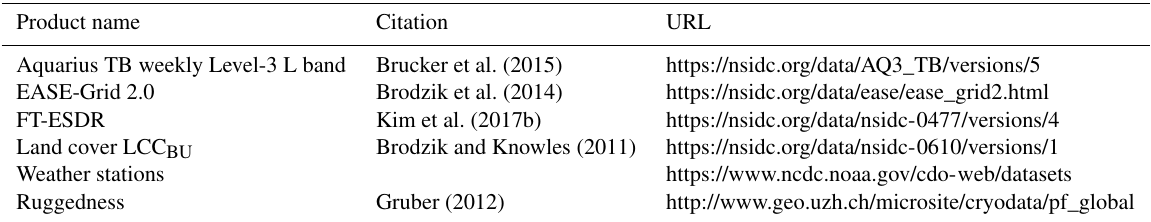
Table 6. Product name, citation and URL for each dataset used in this